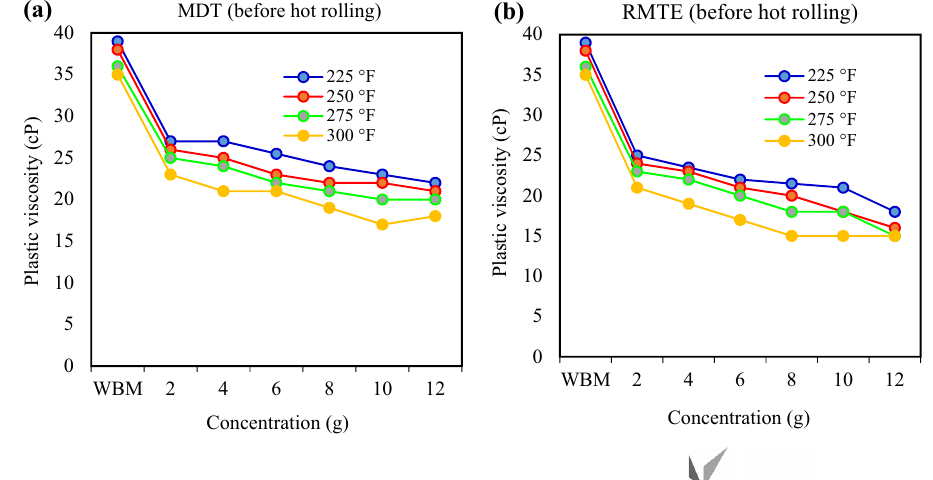
Fig. 6 Plastic viscosity of a MDT and b RMTE at different